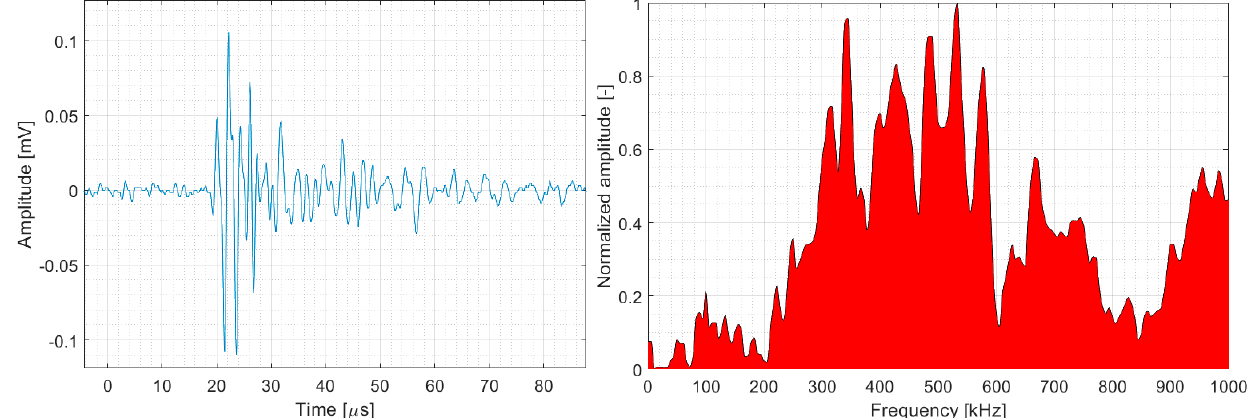
Figure 29. Representative AE signal of fibre failure (DWC 454 dataset).